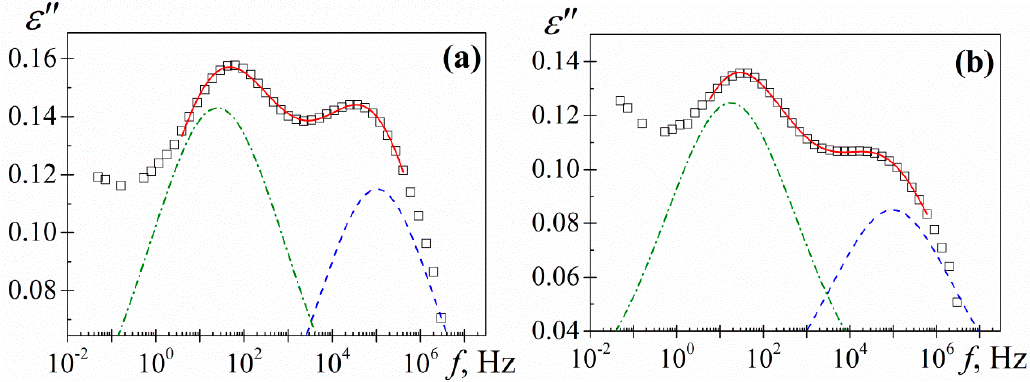
Figure 10. Deconvolution of loss factor for ( a ) PAzMa1 and ( b ) PAzMa2 at − 70 °C. Squares represent the experimental data, continuous line the HN fitting curve and dashed lines the individual processes.